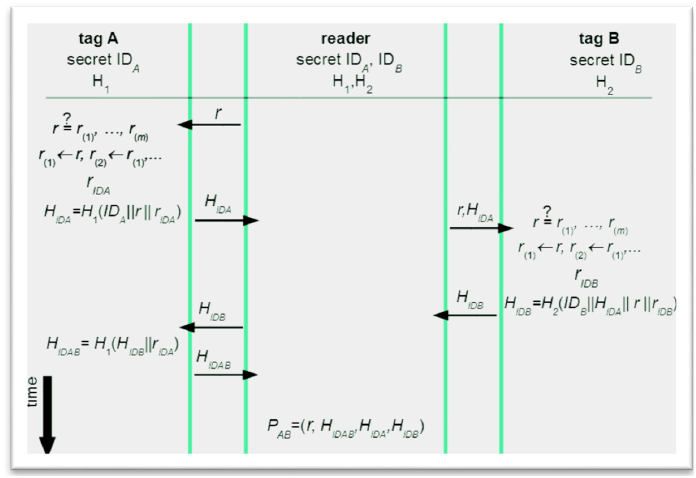
Figure 5. Yoking proof based grouping scheme enhanced by ND-PEPS.